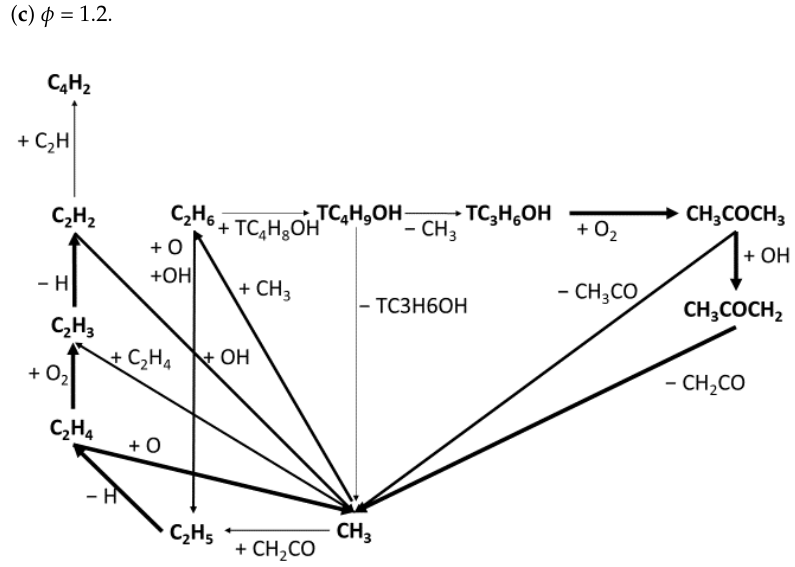
Figure 19. Reaction path diagram for tert-butanol oxidation at 860 K, 36 atm and ϕ = 0.75 with the C4 mechanism. C4